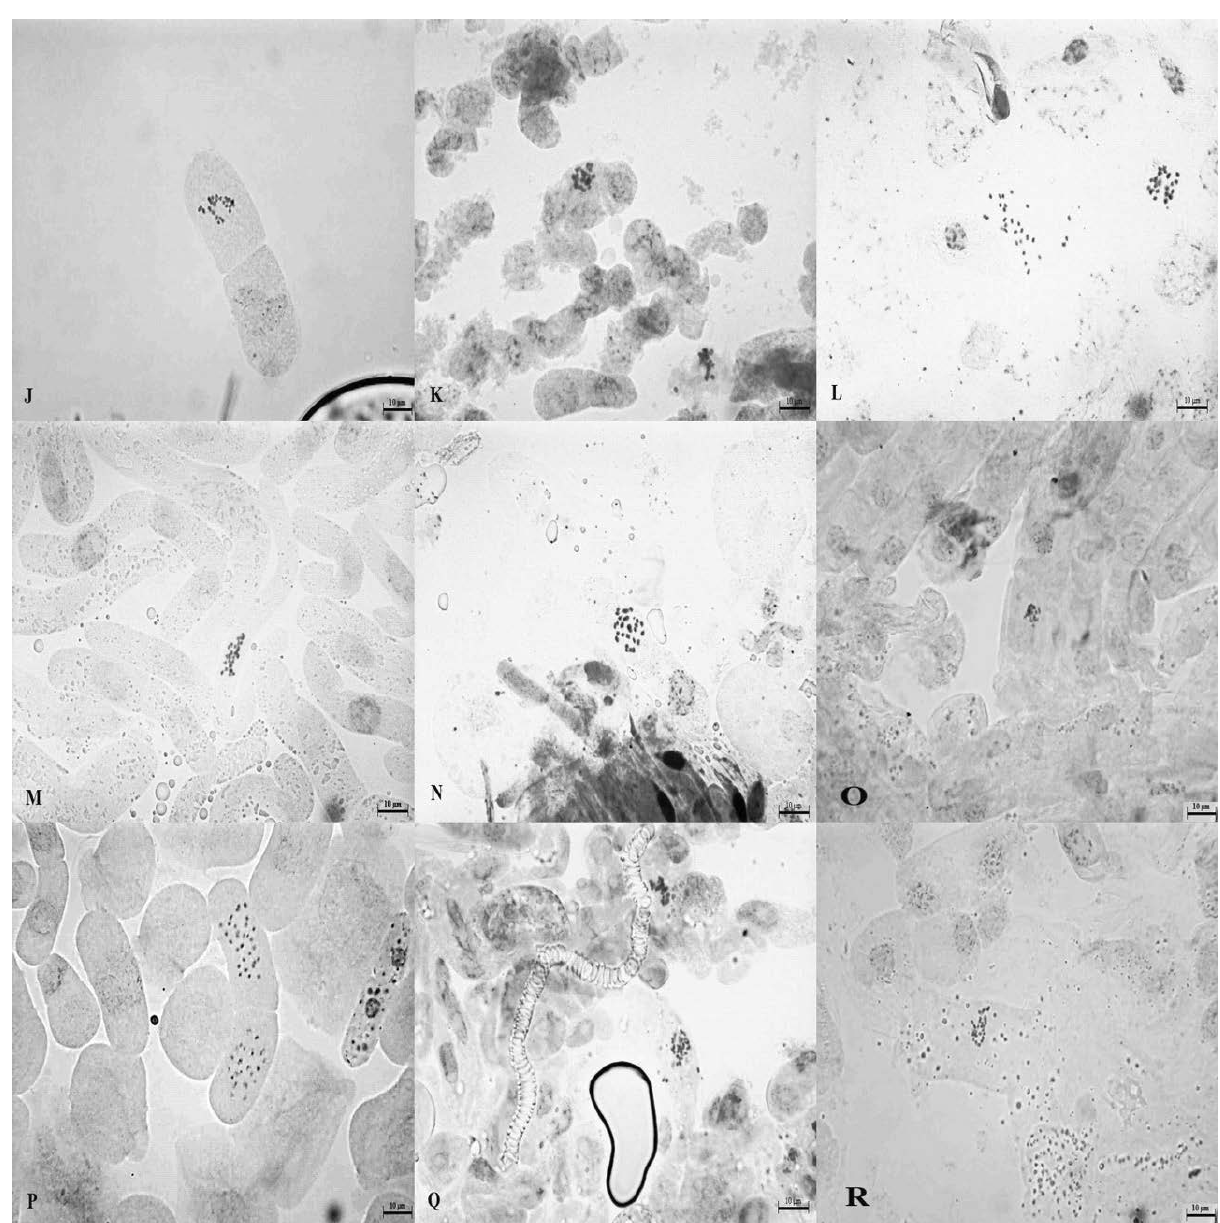
Figure 1J-R. Somatic metaphase chromosomes of Origanum taxa: J) O. husnucan-baseri (TD4528); K) O. leptocladum (TA4345); L) O. rotundifolium (TD3943); M) O. bilgeri (TD4343); N) O. minutiflorum (TD4348); O) O. vogelii (TD4509); P) O. amanum (TD4514a); Q) O. majorana (TD3984); R) O. onites (TD4725). Scale bar: 10